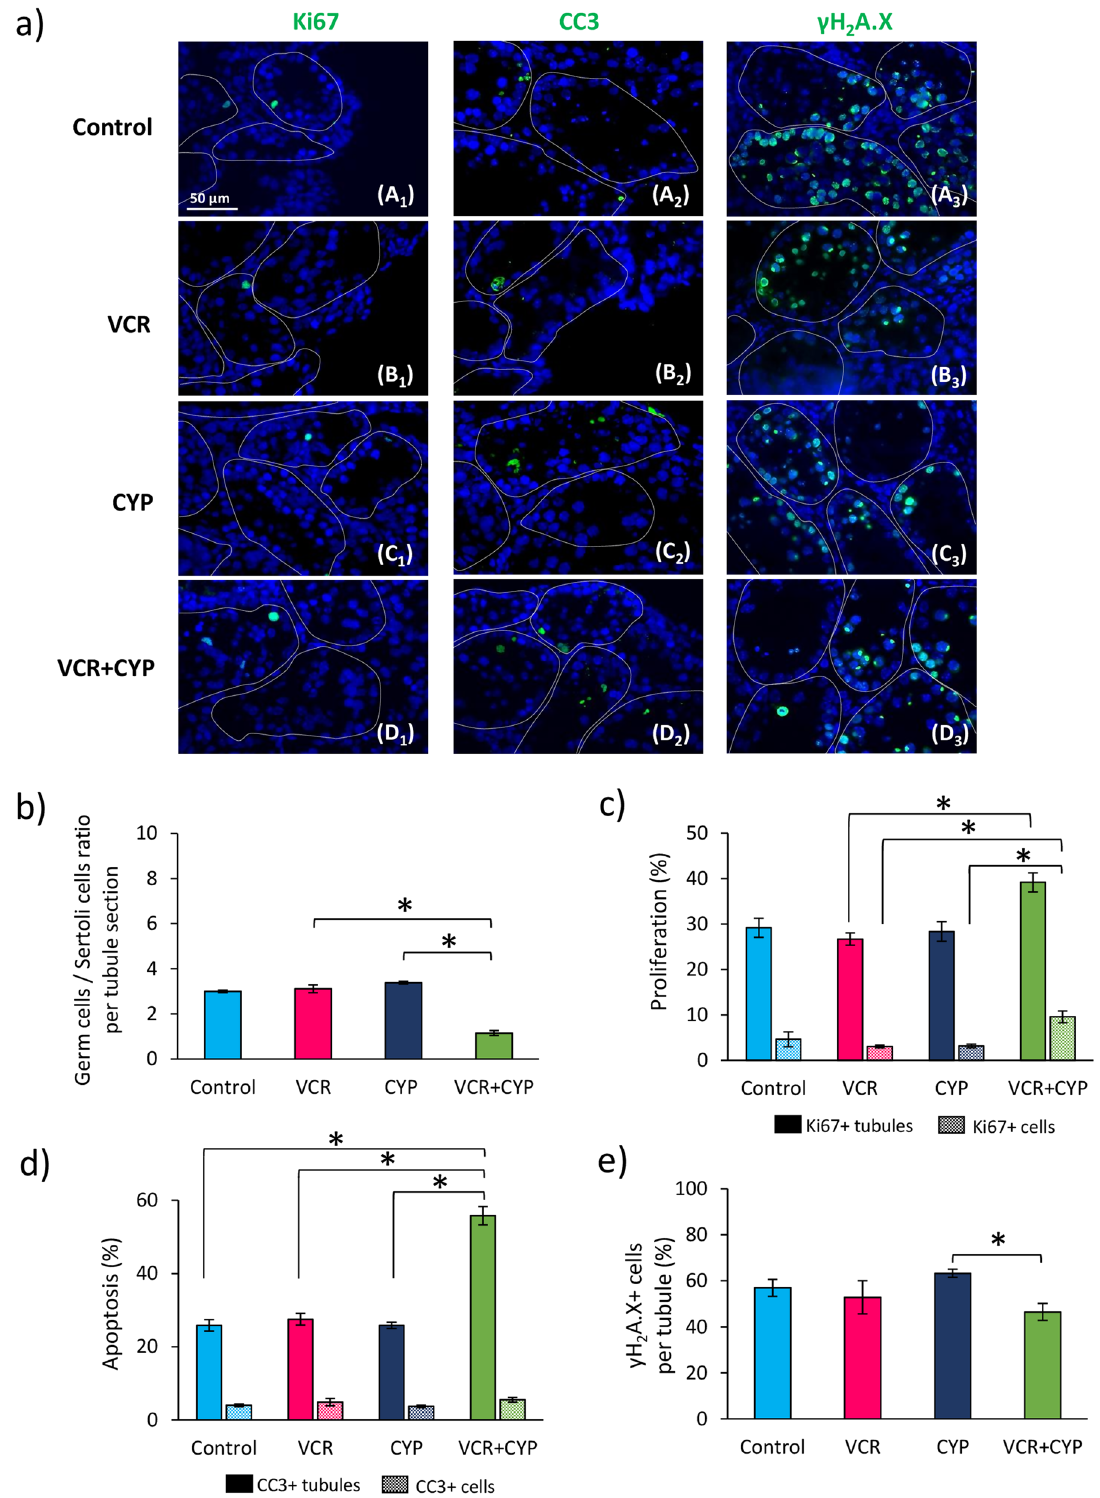
Figure 4. Impact of chemotherapy prepubertal exposure on intratubular cell following 30 days of in vitro maturation. ( a ) Representative images of Ki67 (A1–D1), cleaved caspase-3 (A2–D2) and γH 2 A.X (A3–D3) immunofluorescence in testicular tissues from control, VCR, CYP or VCR+CYP-treated mice after 30 days of culture. Testicular tissue sections were counterstained with DAPI (blue). ( b ) Histogram representing the mean ratio of germ cells to Sertoli cells per seminiferous tubule in cultured testicular fragments for each group. Ki67, cleaved caspase-3 and γH 2 A.X immunodetection was performed to determine ( c ) the percentage of intratubular cell proliferation (Ki67+ tubules in solid colour and Ki67+ cells in hatch colour), ( d ) apoptosis (Caspase 3+ tubules in solid colour and cleaved caspase 3+ cells in hatch colour) and ( e ) intratubular cells with DNA double-strand breaks for each condition. The results are presented as means ± SEM with n = 4 testicular explants for all groups. A value of * P < 0.05 was considered statistically significant. Magnification